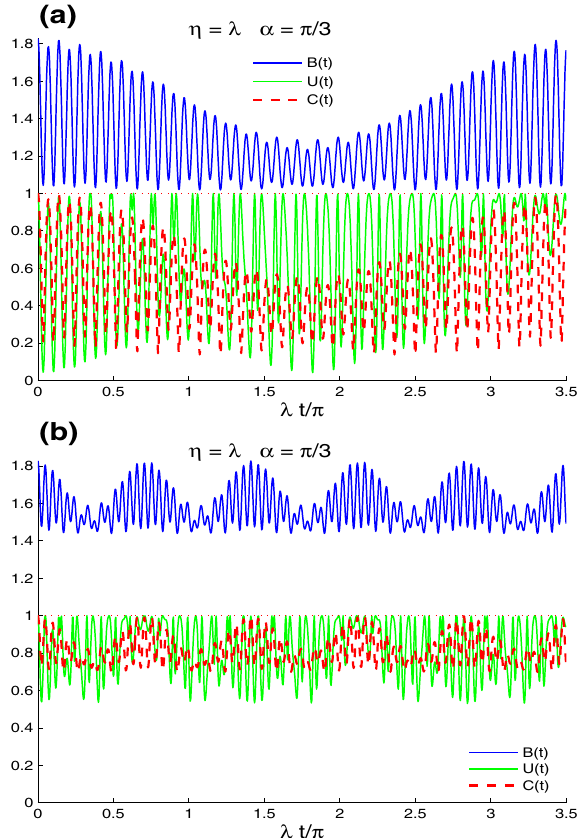
(cid:31) and the maximally correlated state: π/ 3 , η = =